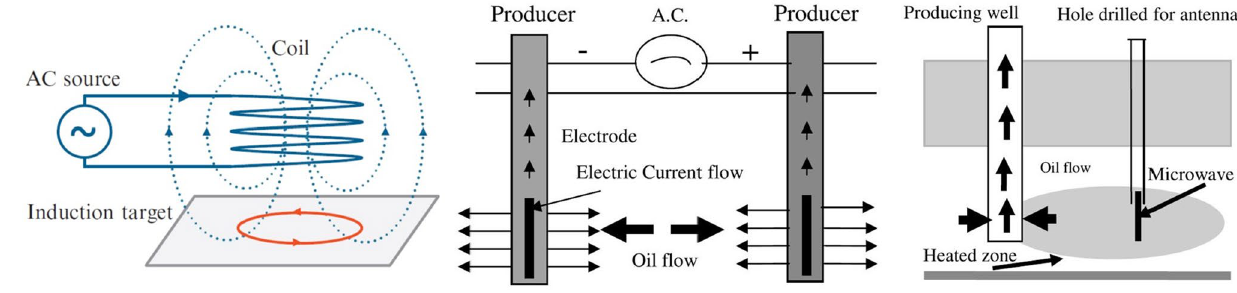
Fig. 2 Schematic of IH (Lucía et al. 2018) (left), low-frequency (middle) and high-frequency (right) (Chhetri and Islam